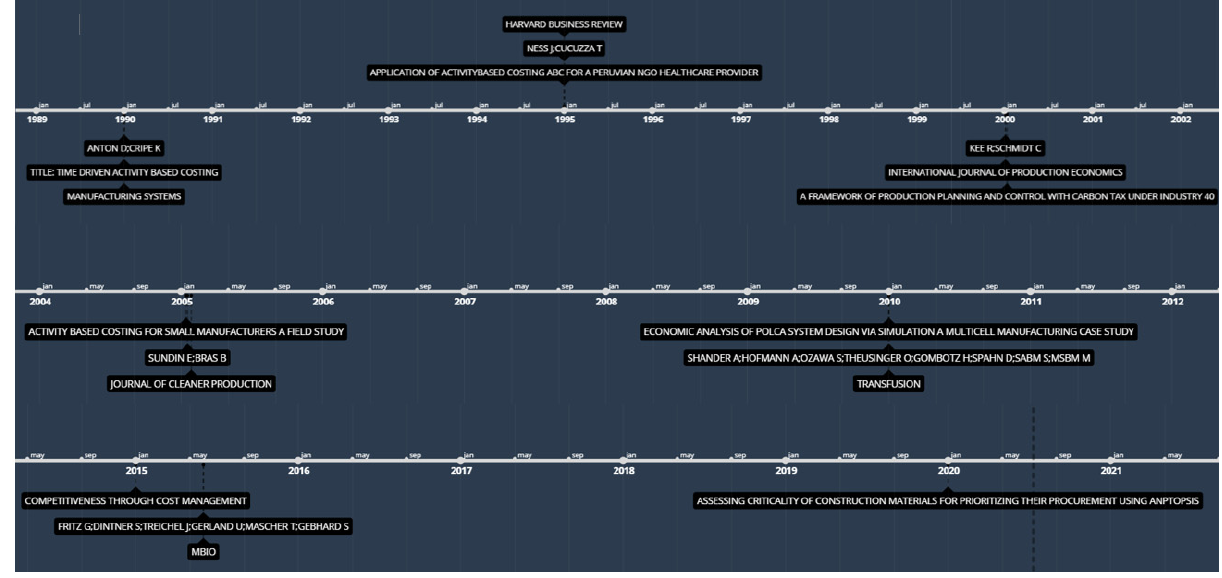
Figure 2. Most cited publications every five years.